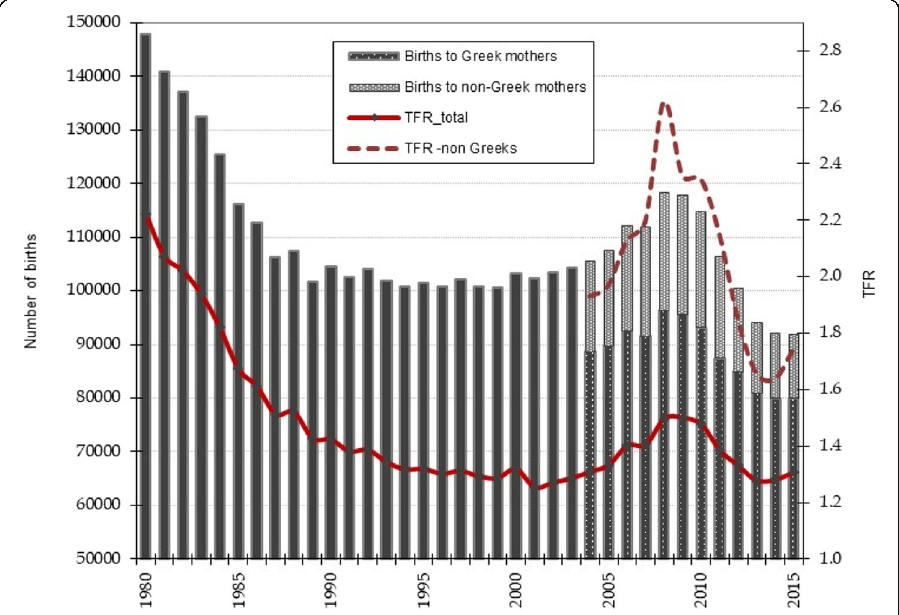
Fig. 1 Number of births and TFR, 2000 – 2015 . The distinction of births in respect to mother ’ s citizenship is available only since 2004. TFR for non-Greeks is based on Bagavos et al. (2018) estimations. Source: EL.STAT